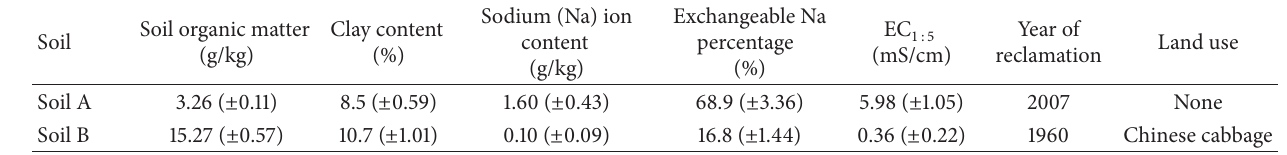
Table 1: Some properties of the soils used in this study.